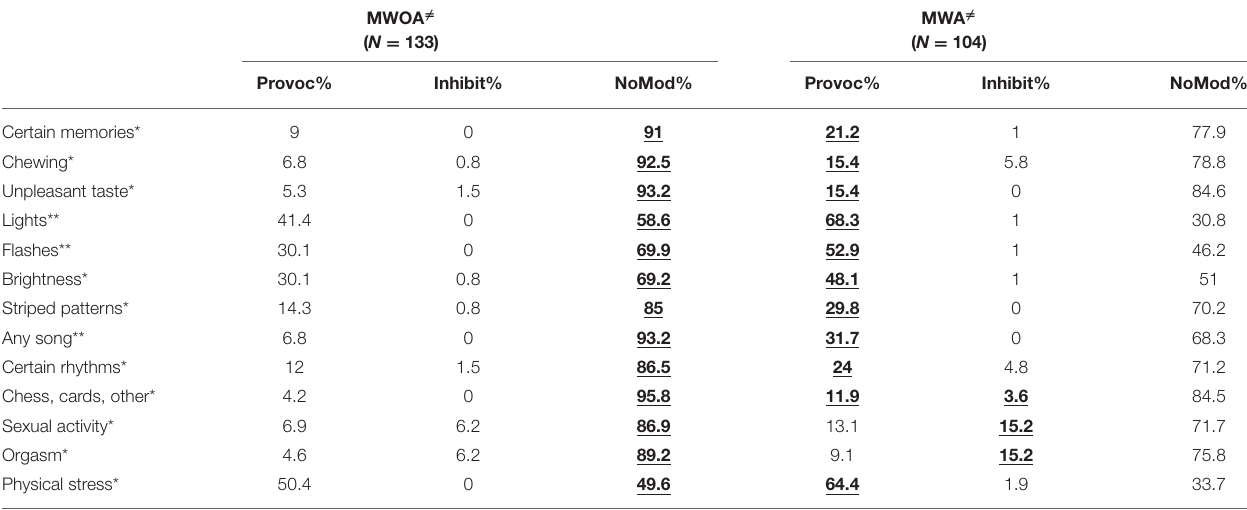
TABLE 6 | Modulatory factors with significant difference between migraine with and without aura.